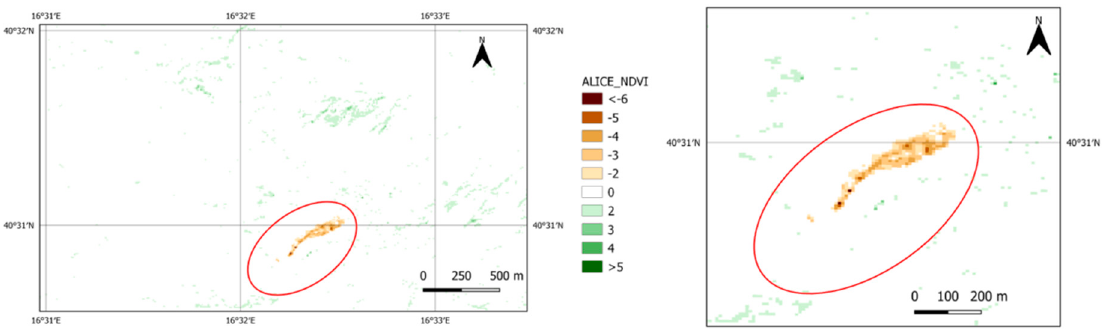
Figure 5. ⊗ NDVI ( x,y,t ) computed for the Sentinel-2 L1C image of 9th February 2019 at 09.40 GMT. The area affected by the landslide is in the red ellipse.